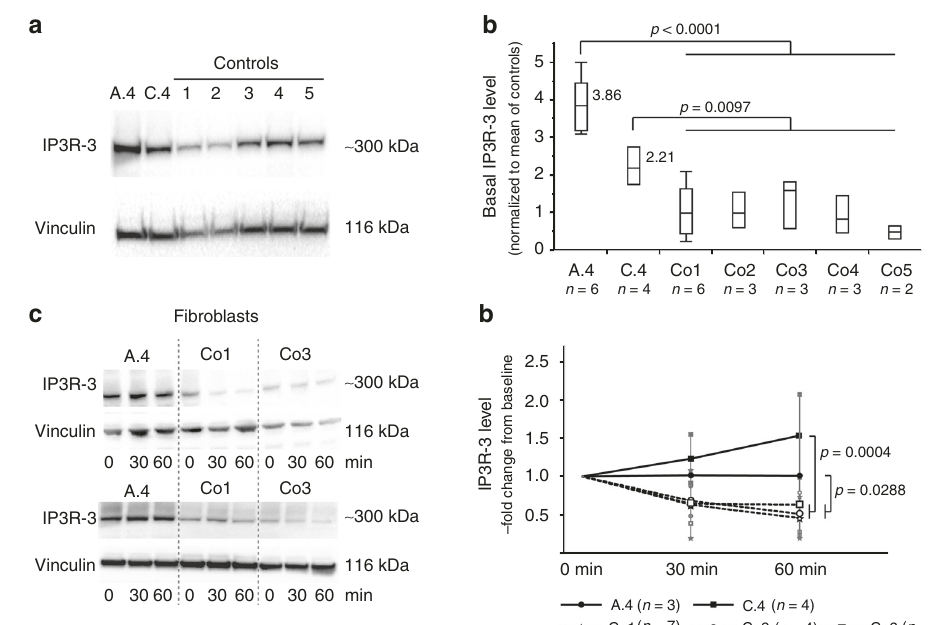
Fig. 2 Loss of RNF170 results in decreased degradation of IP3R-3 in patient fi broblasts. a Immunoblot analysis of IP3R-3 in fi broblasts derived from individuals A.4 and C.4 shows increased expression levels in comparison with fi ve controls (Co1, Co2, Co3, Co4, Co5). Western blots from a representative experiment are shown. b Semiquantitative immunoblot analysis indicates signi fi cantly increased (Tukey – Kramer HSD, t-sided) IP3R-3 expression. In the quantile blot, boxes indicate the 1st and 3rd quartile and median (center line); whiskers depict the 1st/3rd quartile ± 1.5* interquartile range). c , d IP3R-3 was activated by bradykinin stimulation of fi broblasts to trigger RNF170-dependent IP3R-3 degradation by the proteasomal system. IP3R-3 levels were assessed at baseline as well as 30 and 60 mins after stimulation. Physiological IP3R-3 reduction was observed in all three control cell lines (Co1, Co2, Co3), whereas levels were unaltered in patient-derived fi broblasts (derived from patients A.4 and C.4) (full-factorial repeated measures analysis; means and standard deviations are shown for each data